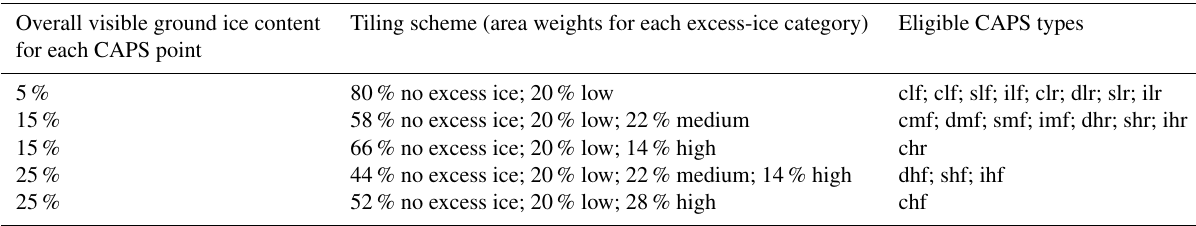
Table 2. The tiling scheme prescribing area weights of land units for each CAPS class. The detailed CAPS classes are shown in Fig. 2. Overall visible ground ice content Tiling scheme (area weights for each excess-ice category)